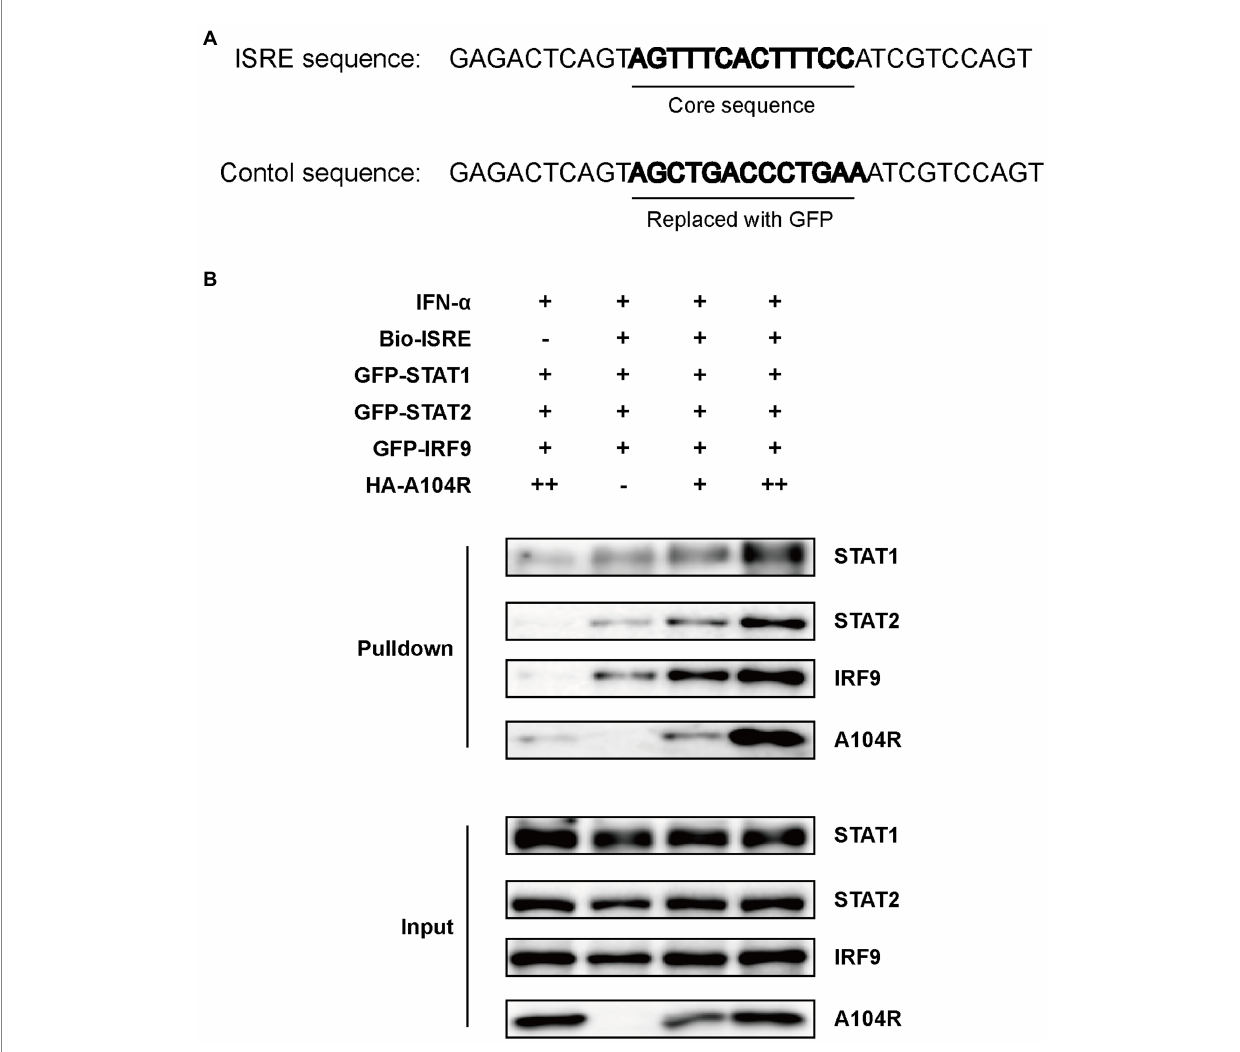
FIGURE 5 ASFV pA104R does not prevent the association of ISGF3 with promoter. (A) The ISRE DNA and control oligonucleotides used for DNA pull-down. (B) HEK-293T cells were co-transfected with ISGF3 complex (STAT1, STAT2, and IRF9), along with pA104R or empty control. After 24 h post- transfection, cells were treated with 1,000 U/mL IFN- α for 12 h. Nuclear extracts were incubated with a Biotin-labeled ISRE or control probe and subjected to pull-down analysis with streptavidin magnetic beads. The whole-cell lysates and pull-down complexes were analyzed by immunoblotting with the indicated